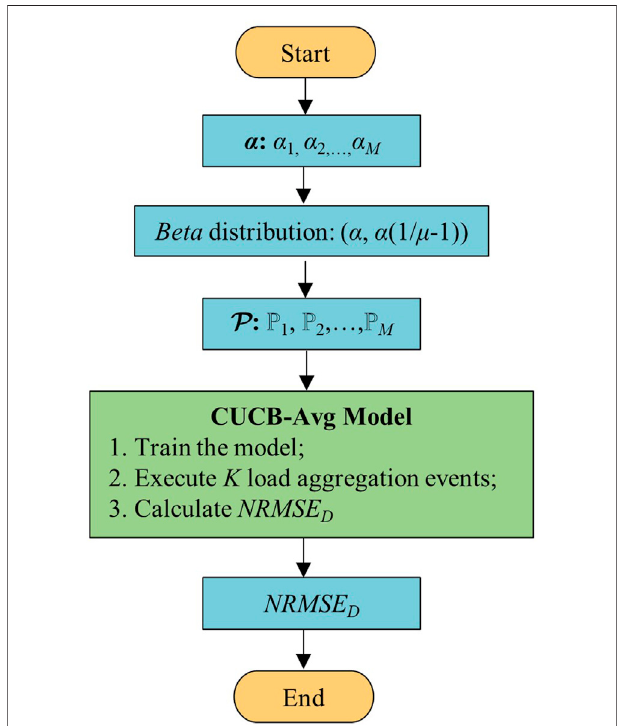
FIGURE 1 | Evaluation